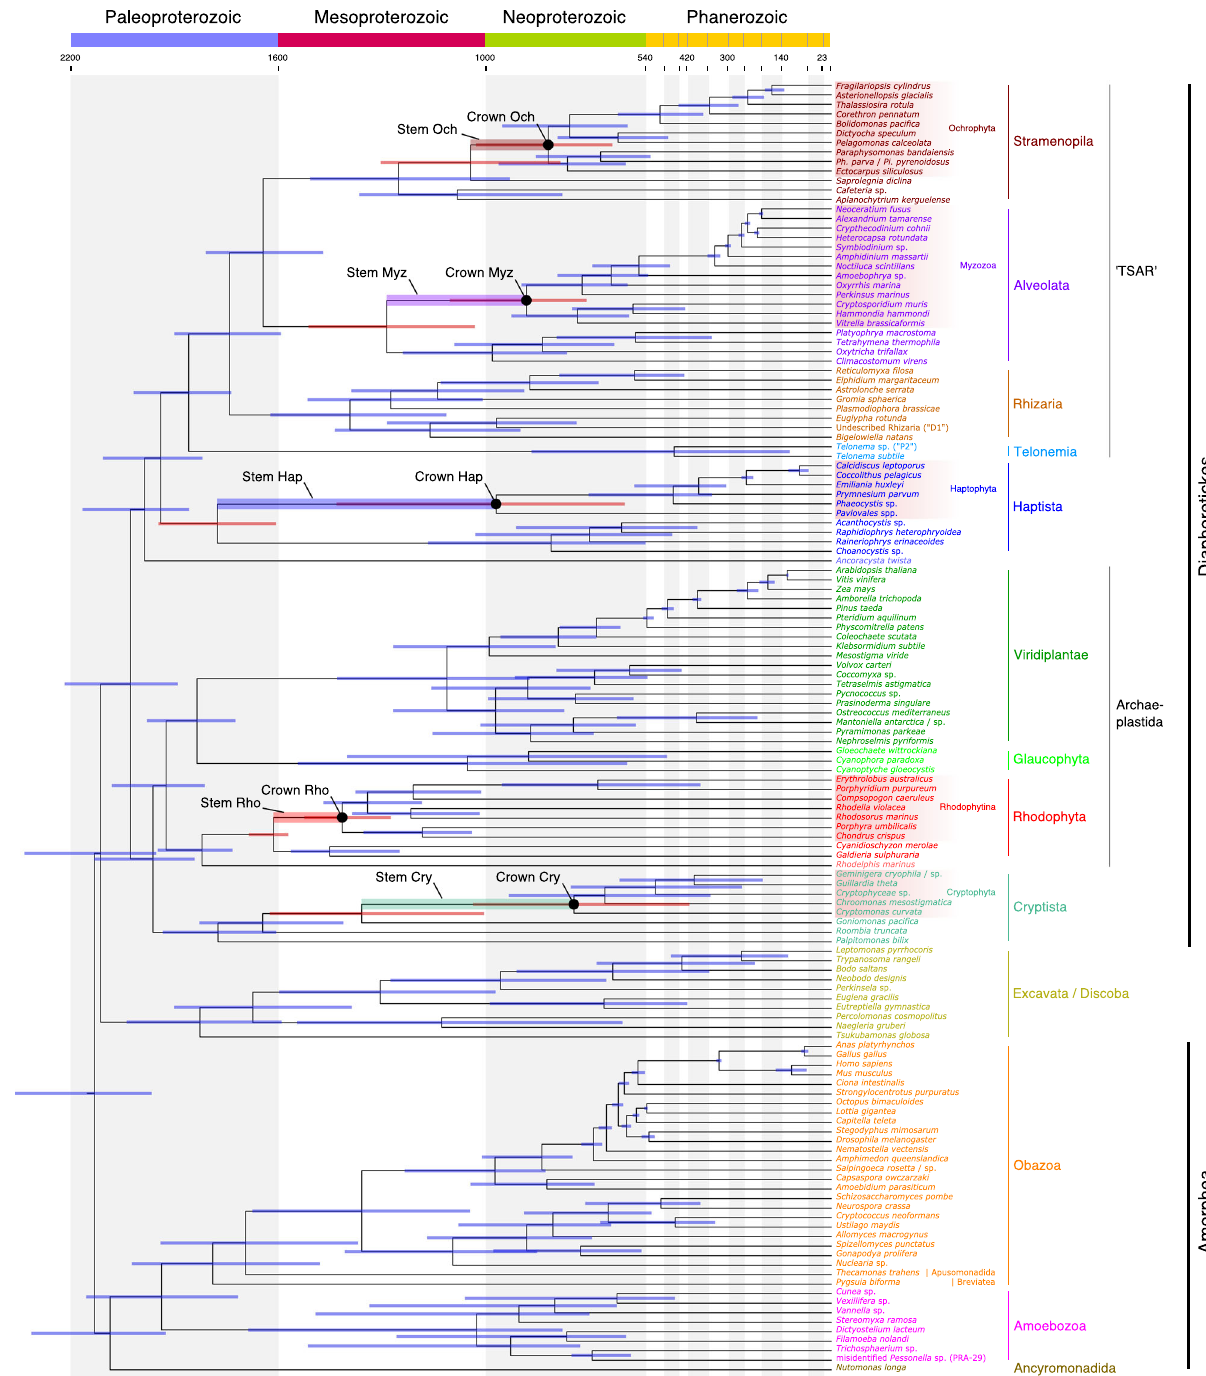
Fig. 3 Time-calibrated phylogeny of extant eukaryotes. Divergence times were inferred with MCMCTree under an autocorrelated relaxed clock model and 33 fossil calibration points as soft-bound uniform priors (Table 1). The tree topology was reconstructed using IQ-TREE under the LG + C60 + G + F model and a constrained tree search following the OTU-reduced Bayesian CAT + GTR + G topology (Supplementary Fig. 4). Approximate likelihood calculations on the 320 gene concatenation under LG + G and a birth – death tree prior were used. Bars at nodes are 95% HPD. Bars corresponding to the fi rst and last common ancestors of extant red plastid-donating and -containing lineages are highlighted in red and their stems are shaded as indicated. Crowns denote the common ancestors of the extant members of these groups. An absolute time scale in Ma and a geological time scale are shown. The tree depicted here was rooted on Amorphea. An equivalent time-calibrated tree rooted on Excavata is shown in Supplementary Fig. 7. Cry Cryptophyta, Hap Haptophyta, Myz Myzozoa, Och Ochrophyta, Rho